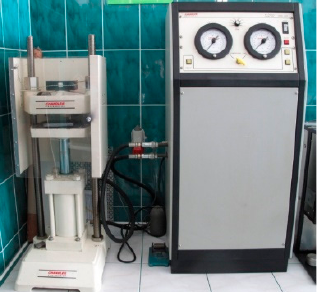
Figure 5. Chandler Engineering testing machine.